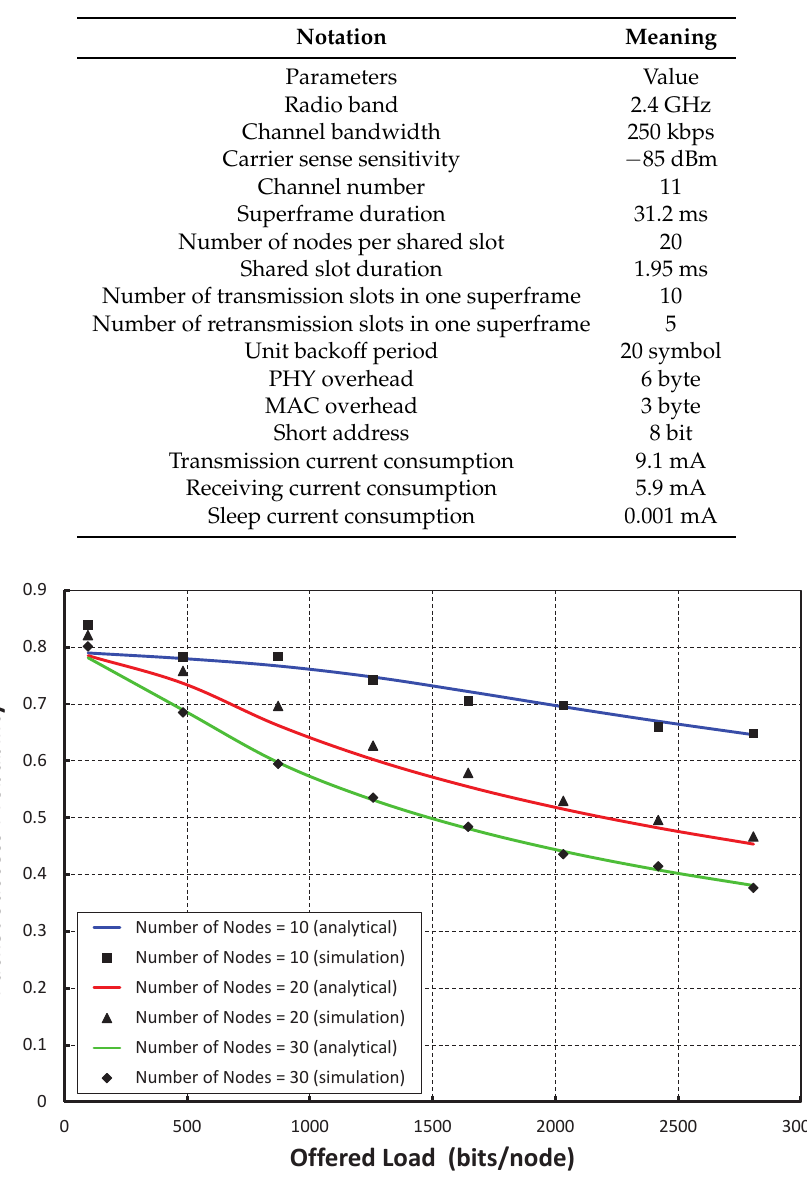
Figure 4. Validation for packet success probability with different offered